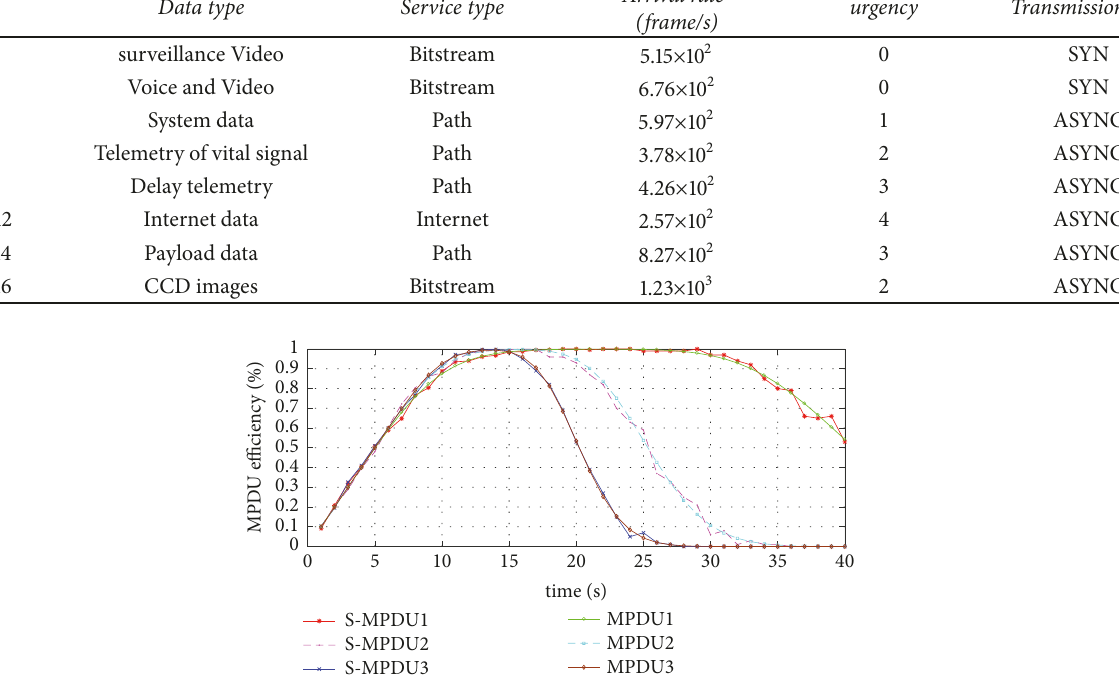
Figure 3: Relationship between the M PDU efficiency and frame